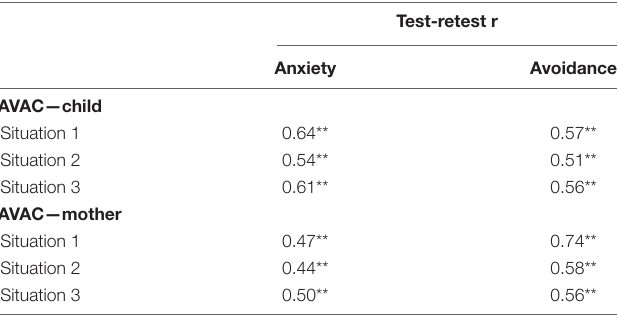
TABLE 1 | Test-retest reliability (Pearson correlations) of child and mother-version of the AVAC.